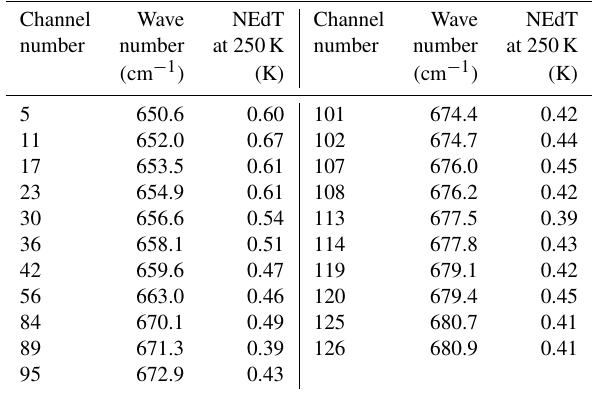
Table 1. AIRS radiance channels of the 15µm brightness tempera- ture data